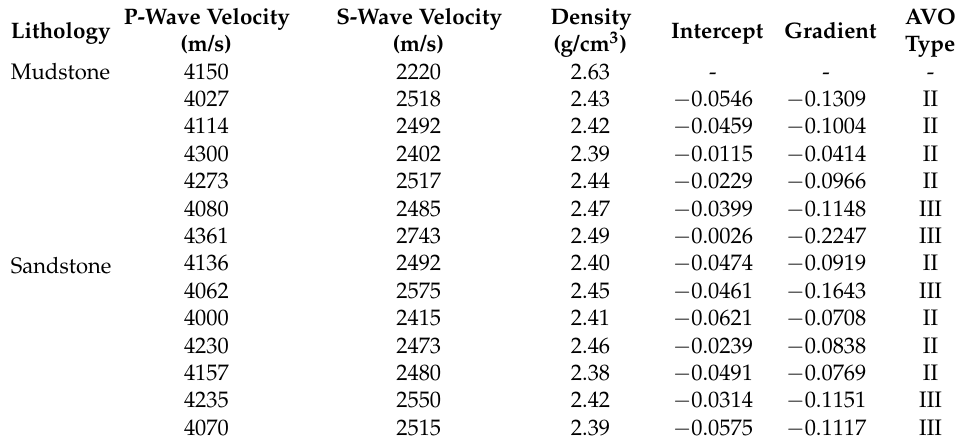
Table 3. Statistics concerning elastic parameters and AVO characteristics of drilled sandstone in the Pingbei slope